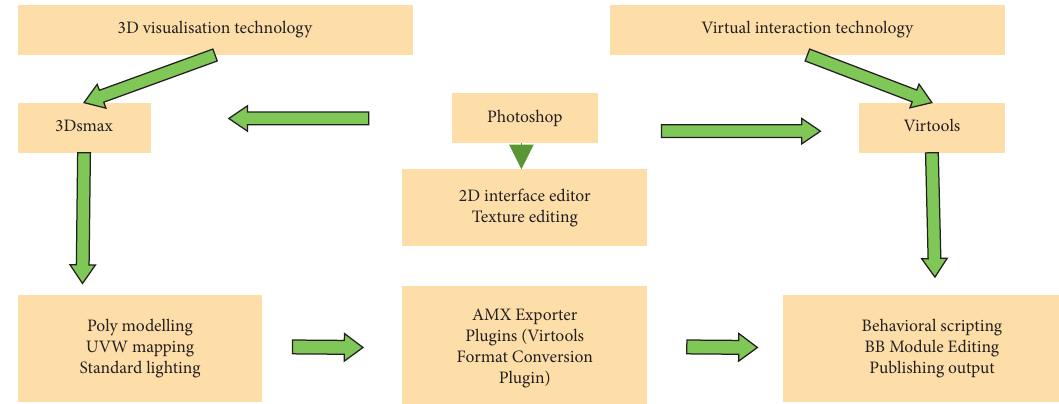
Figure 5: A virtual interactive display design to realize the 3D effect of ancient buildings on the PC.